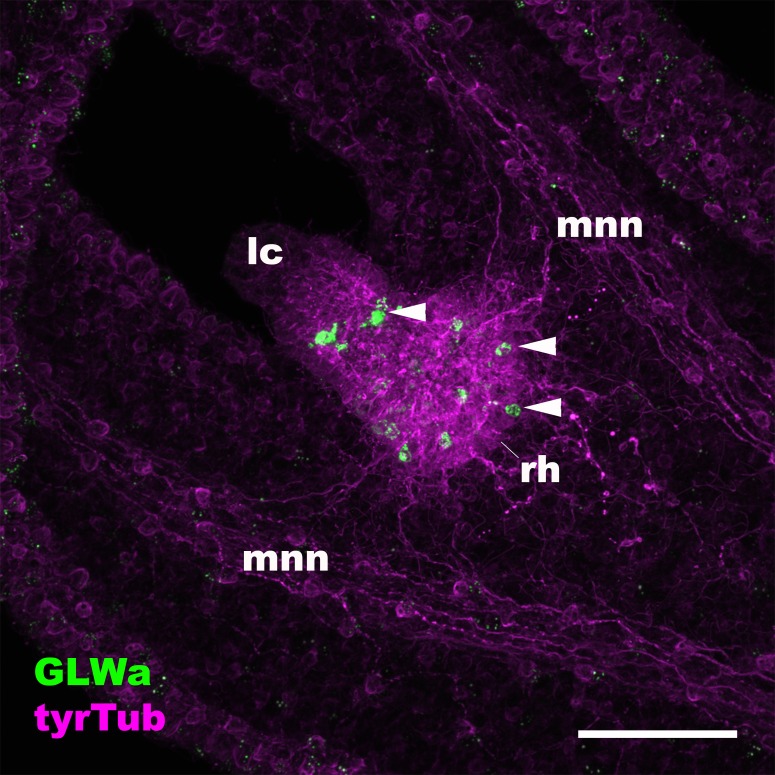
The anti-GLWamide antibody used in this study labels a subpopulation of ectodermal sensory cells of the rhopalial nervous system in the scyphozoan cnidarian Aurelia sp.1.Confocal sections of a free-swimming ephyra of Aurelia sp.1, labeled with antibodies against GLWamide (‘GLWa’) and tyrosinated ∂-tubulin (‘tyrTub’). The panel shows an oral view of a rhopalium (rh) with its distal end (i.e. a lithocyst (lc)) pointing toward the upper left. Arrowheads show GLWamide-positive ectodermal sensory cells that are clustered in the proximal region of the rhopalium. This immunostaining pattern is consistent with that previously documented by using an antibody against EQPGLWamide (Nakanishi et al., 2009), indicating that the anti-GLWamide antibody used in this study can cross-react with GLWamides with divergent N-terminal sequences. Abbreviation: mnn motor nerve net. Scale bar: 50 µm.